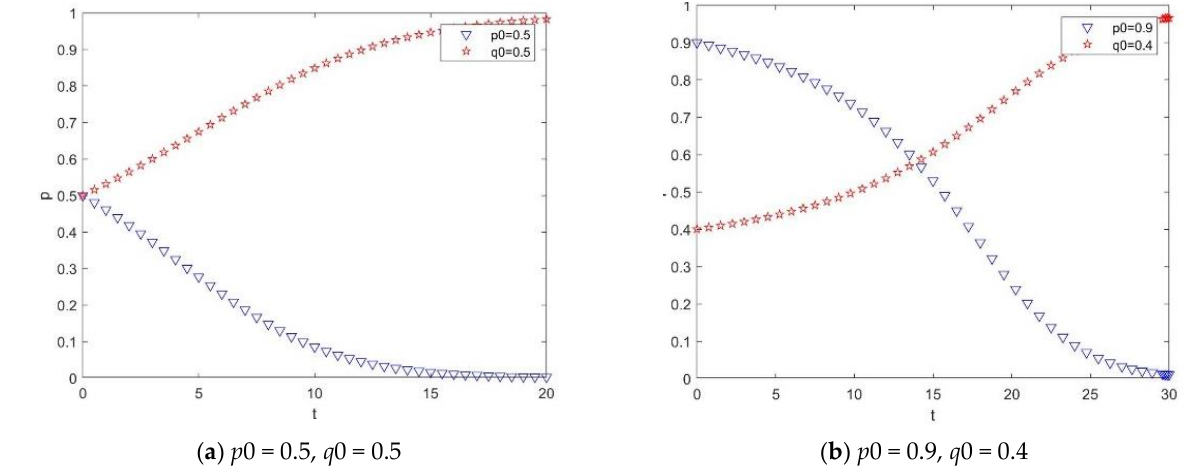
( b ) p 0 = 0.9, q 0 = 0.4 Figure 7. The effect of the main contractor’s expected accident loss S 2 on the evolution results. As a result, when the accident losses are expected to be high, the main contractor intensifies safety inspections. This leads to an increase in the intensity and number of in- spections, as well as an increase in the number of penalties for construction workers’ vio- lations. However, the labor savings and bravado rights of violation always outweigh the fines, so the construction workers’ strategy shifts to the violation. As can be seen, the larger the value of S 2, the less likely the system is to jump out of the “bad lock” state. Therefore, when the safety atmosphere is strong, the main contractor will also adopt a